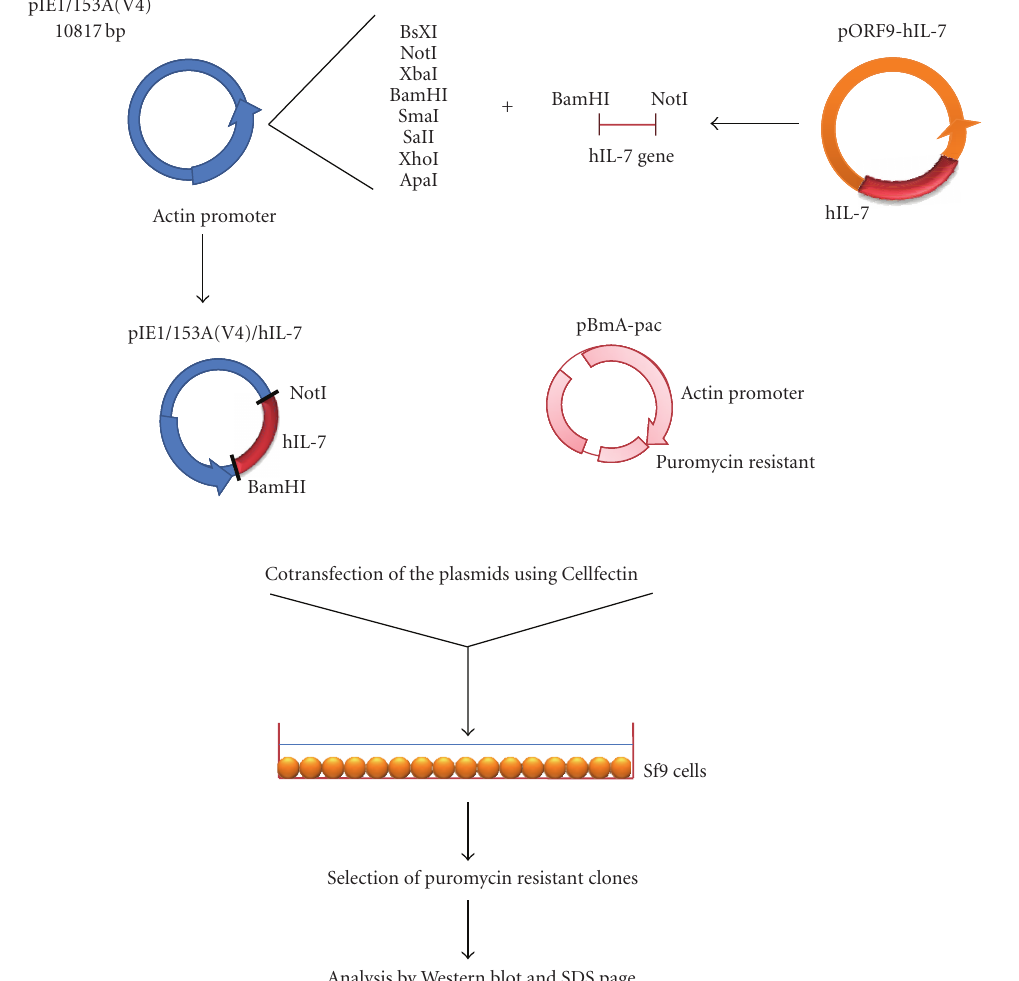
Figure 1: Construction of the pIE1/153A (V4) expression plasmid carrying the hIL-7 gene. The hIL-7 gene from pORF9-hIL07 vector was inserted in pIE1/153A(V4) expression plasmid, pIE1/153A(V4)/hIL-7 and pBmA-pac were cotransfected into Sf9 cells. Clones producing hIL-7 were selected using puromycin and analyzed by western blot and SDS